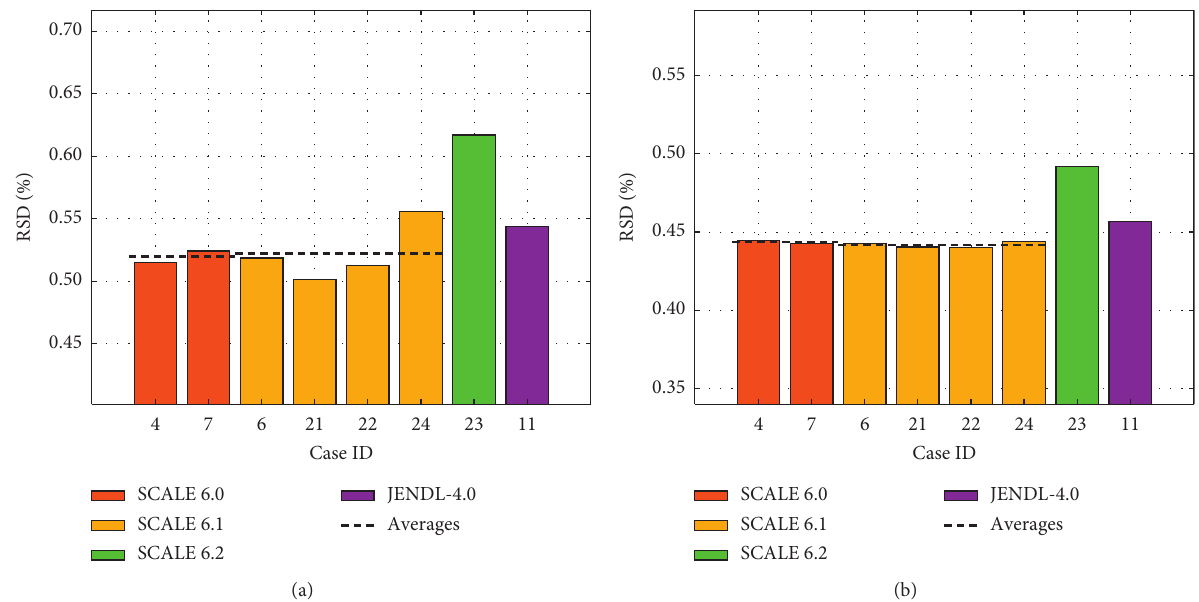
Figure 8: RSD of predicted ] Σ f cross section for unrodded lattice case: (a) fast group and (b) thermal group.